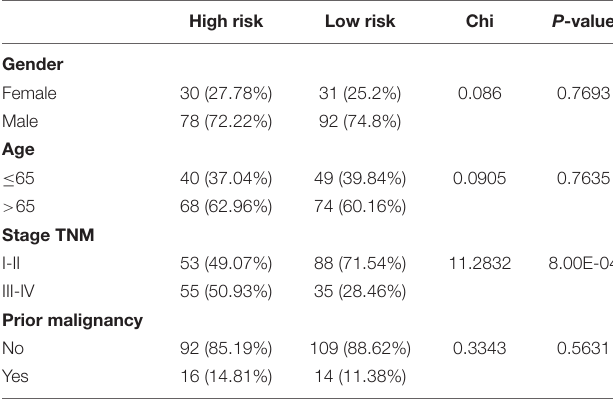
TABLE 3 | The chi-square test of the relation between different risk groups and clinical features in ICGC